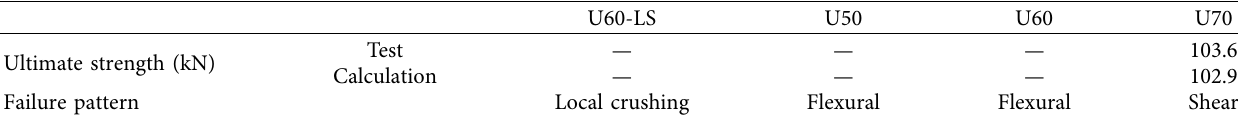
Figure 21: Location of ultimate evaluation point for Texas girders. Table 6: Predicted results for tested composite